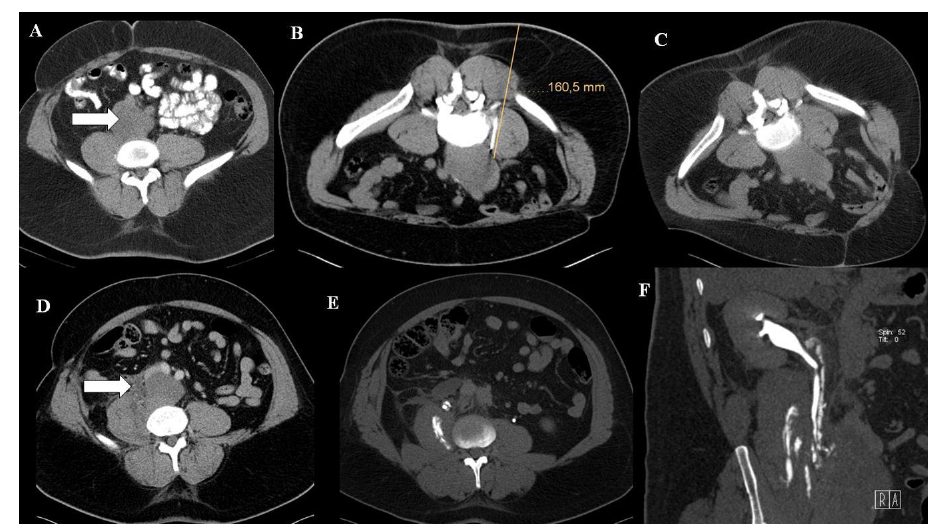
Fig. 3. The ureter injury. Hypovascular mass in lower levels of the retroperitoneum on contrast medium enhanced CT examination (A, arrow). Planning the track and inserting of the biopsy needle (B), patient in prone position. The control CT examination straight after the intervention revealed no complications (C). The histological result was ganglioneuroma. CT examination was performed 6 days after the intervention in the portal venous phase (D) and delayed excretory phase in the transversal plane (E, arrow) and oblique reconstruction (F). The urine leakage proved the ureter